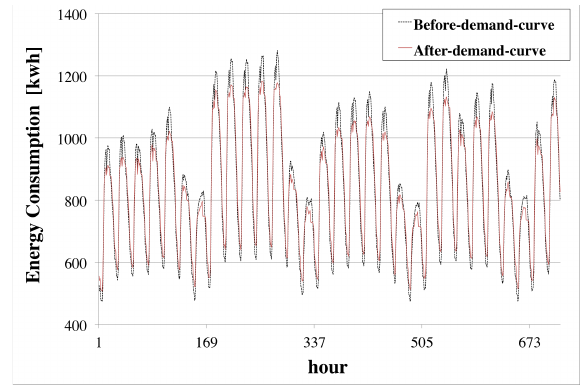
Fig. 4. Energy usage before (black dotted line) and after (red solid line) using of CDR algorithm: 31 days